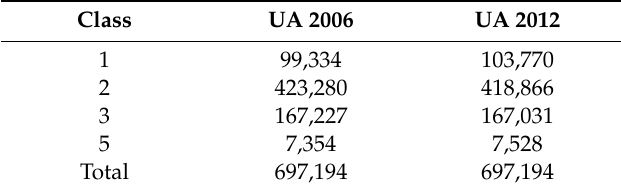
Table 6. The land use / land cover (LU / LC) in the aggregate classes of the UA nomenclature (in ha).